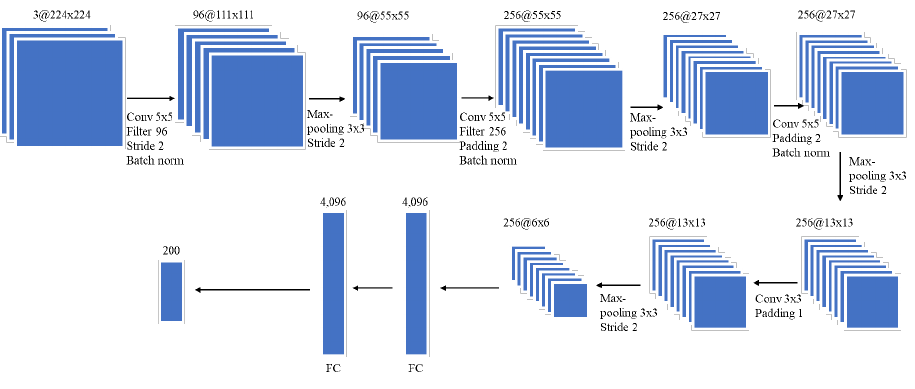
Figure 10. Proposed CNN